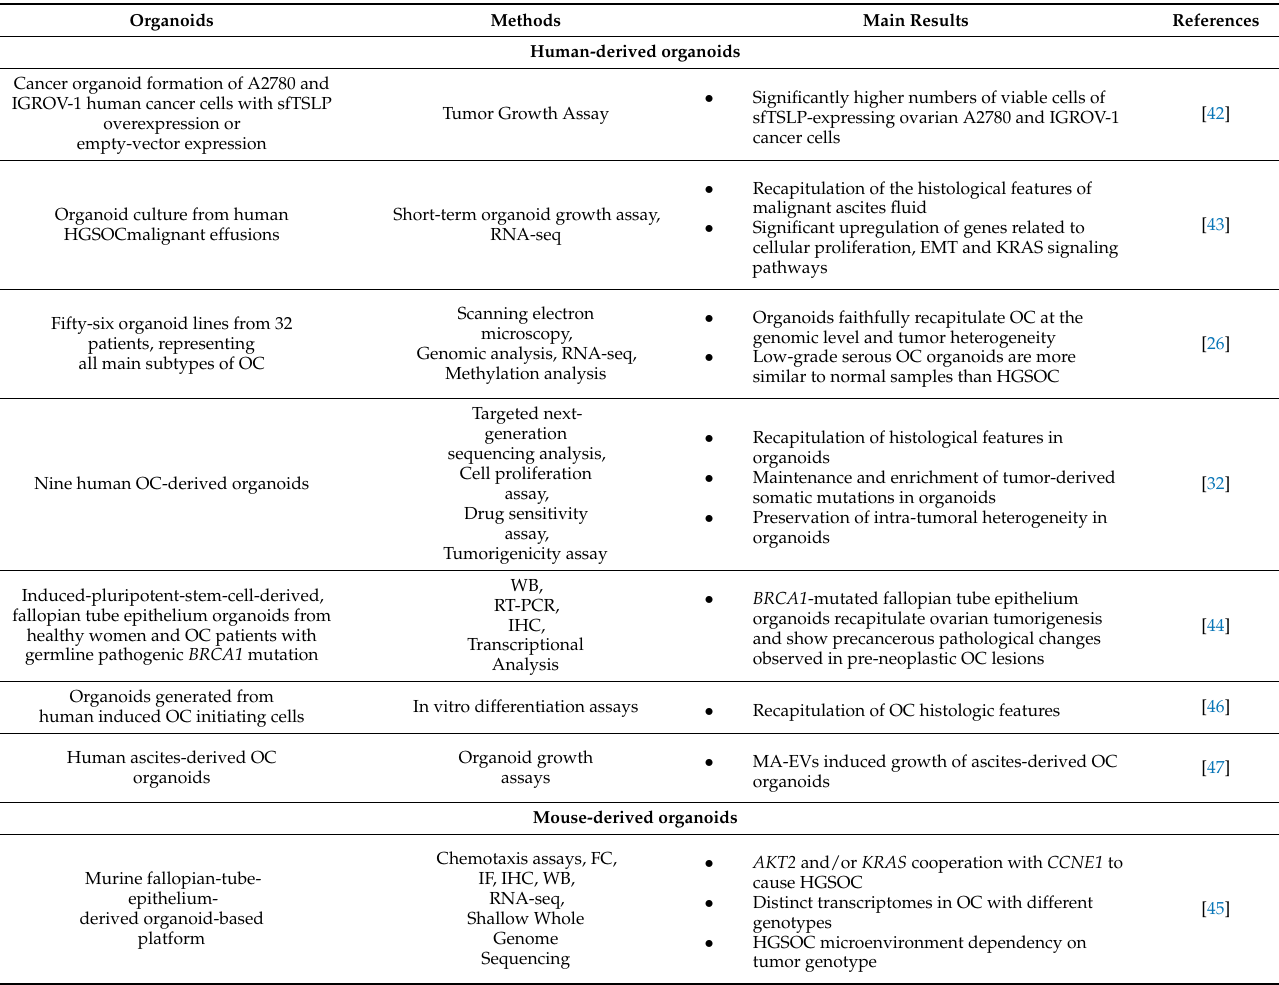
Table 2. The use of organoids as a preclinical model for